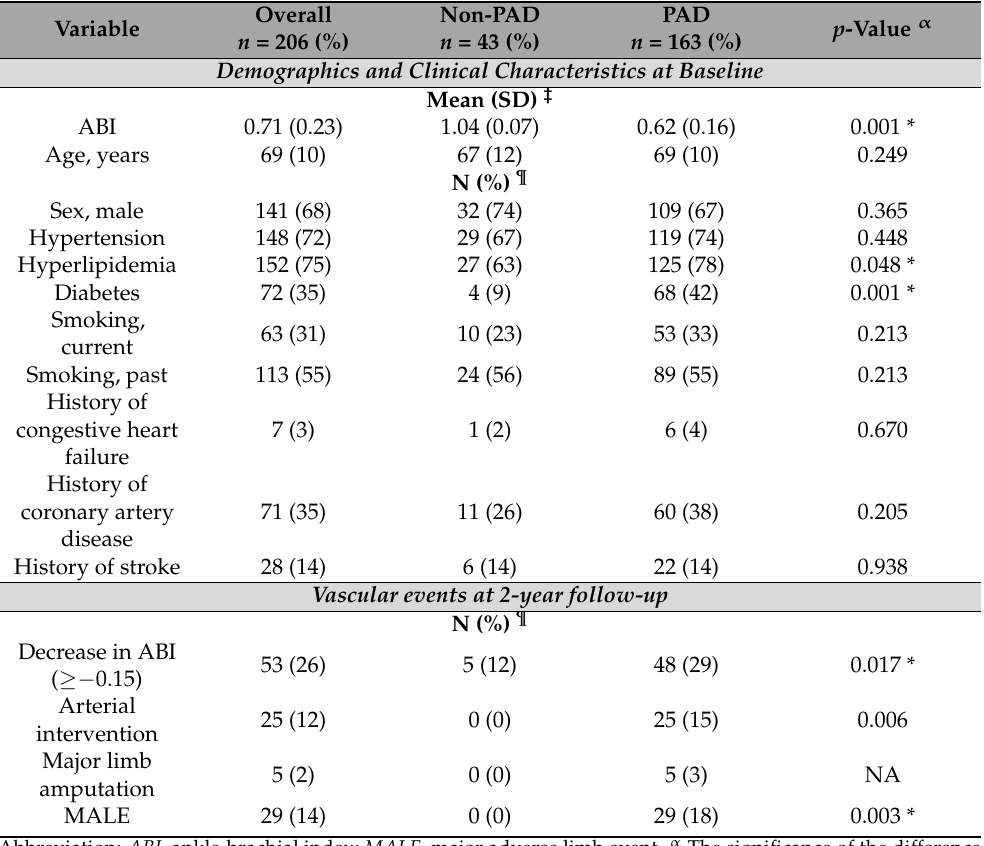
Table 1. Patient demographics and clinical